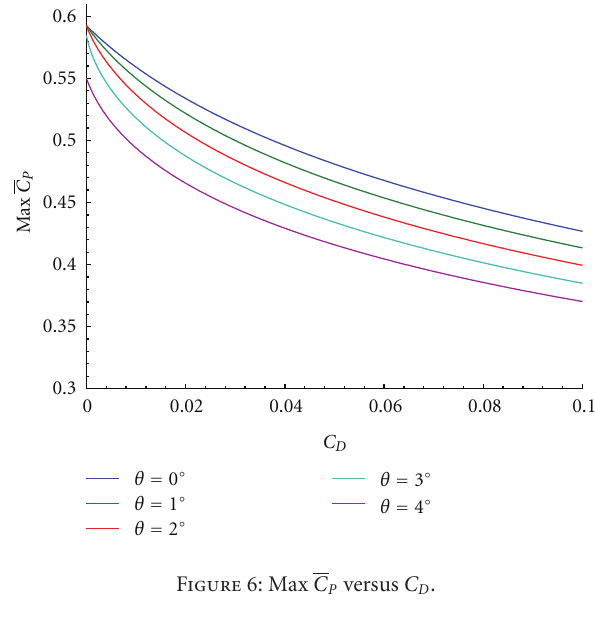
Figure 6: Max C P versus C D .